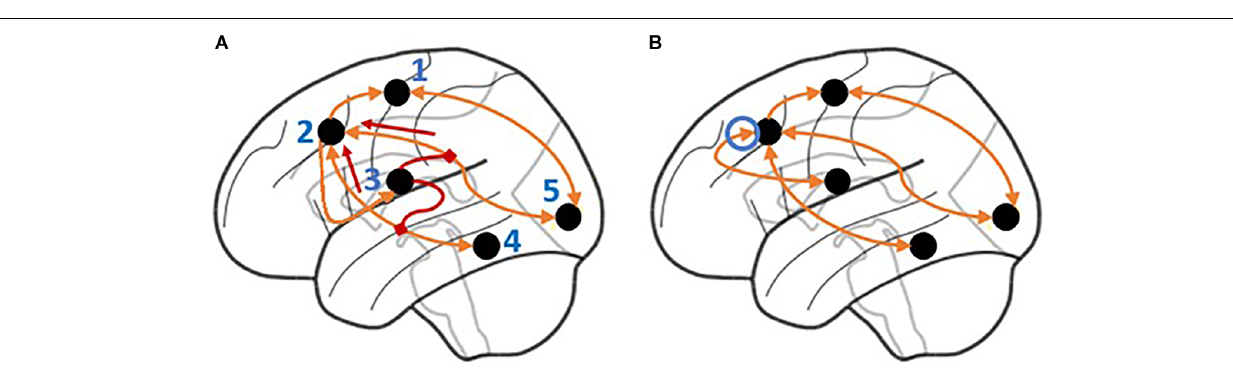
FIGURE 2 | Illustration of the signal flow for the Modulatory and Direct Model. (A) In the Modulatory Model, the basal ganglia modulate the signals flowing through incoming connections to the prefrontal cortex. The connection between the prefrontal cortex and basal ganglia is unidirectional with no direct connection from the basal ganglia to the prefrontal cortex. Short arrows highlight the directionality of the modulatory connections. (B) In the Direct Model, the basal ganglia have a direct (and bidirectional) connection to the prefrontal cortex. The circled arrow highlights the connection that is only present in the Direct model. Regions are labeled as follows: 1. Motor cortex, 2. Prefrontal cortex, 3. Basal ganglia, 4. Hippocampus and medial temporal lobe, 5. Visual, auditory, and sensory